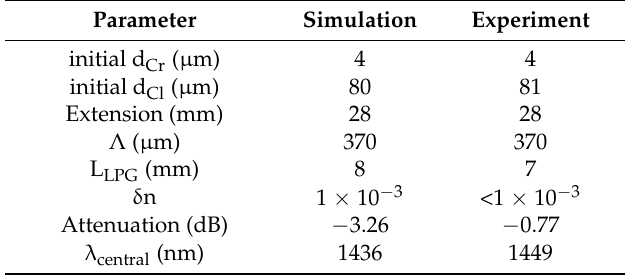
Table 1. Comparison between the simulated and corresponding experimental LPGs.